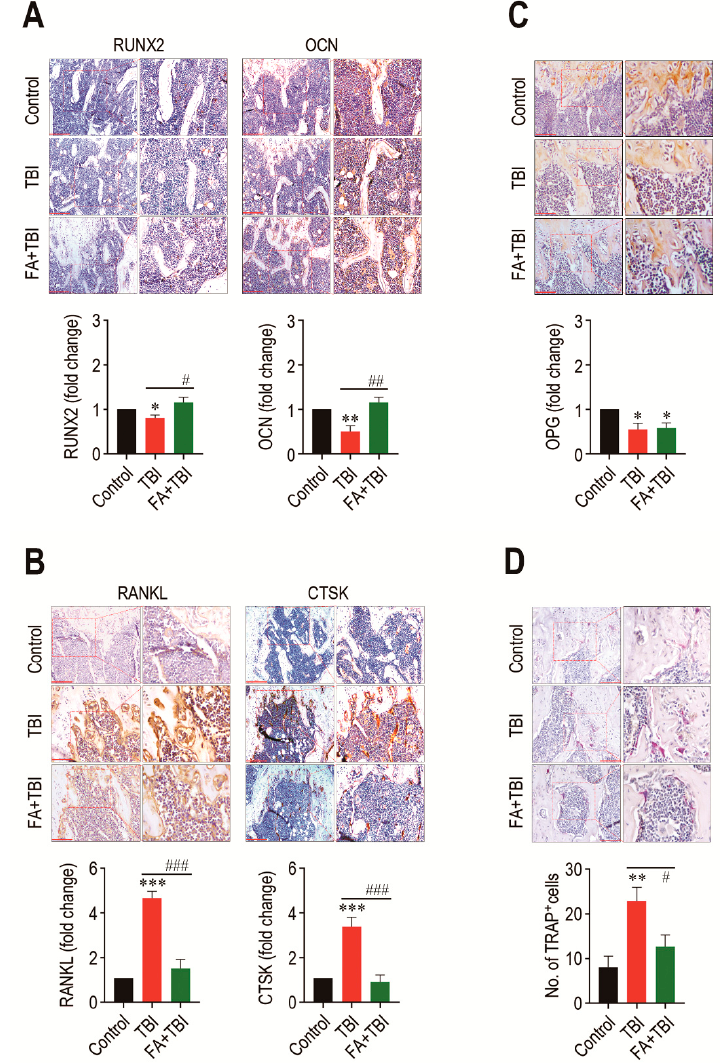
Figure 4. TBI causes an imbalanced activation between osteoblasts and osteoclasts, and this is completely prevented by long-term administration of ferulic acid. Levels of ( A ) RUNX2 and OCN, ( B ) RANKL and CTSK, and ( C ) OPG in BM of mice groups were evaluated by IHC assay at 60 days post-TBI. ( D ) Osteoclasts formed in BM of mice were determined by TRAP staining at the same day after TBI. The IHC images show representative results from four different mice. Scale bars in the images for RUNX2, OCN, and CTSK are 200 μ m, while those for RANKL, OPG, and TRAP are 100 μ m. All data are presented as the mean ± SD ( n = 4). * p < 0.05, ** p < 0.01, and *** p < 0.001 compared with control group; # p < 0.05, ## p < 0.01, and ### p < 0.001 compared with TBI group.